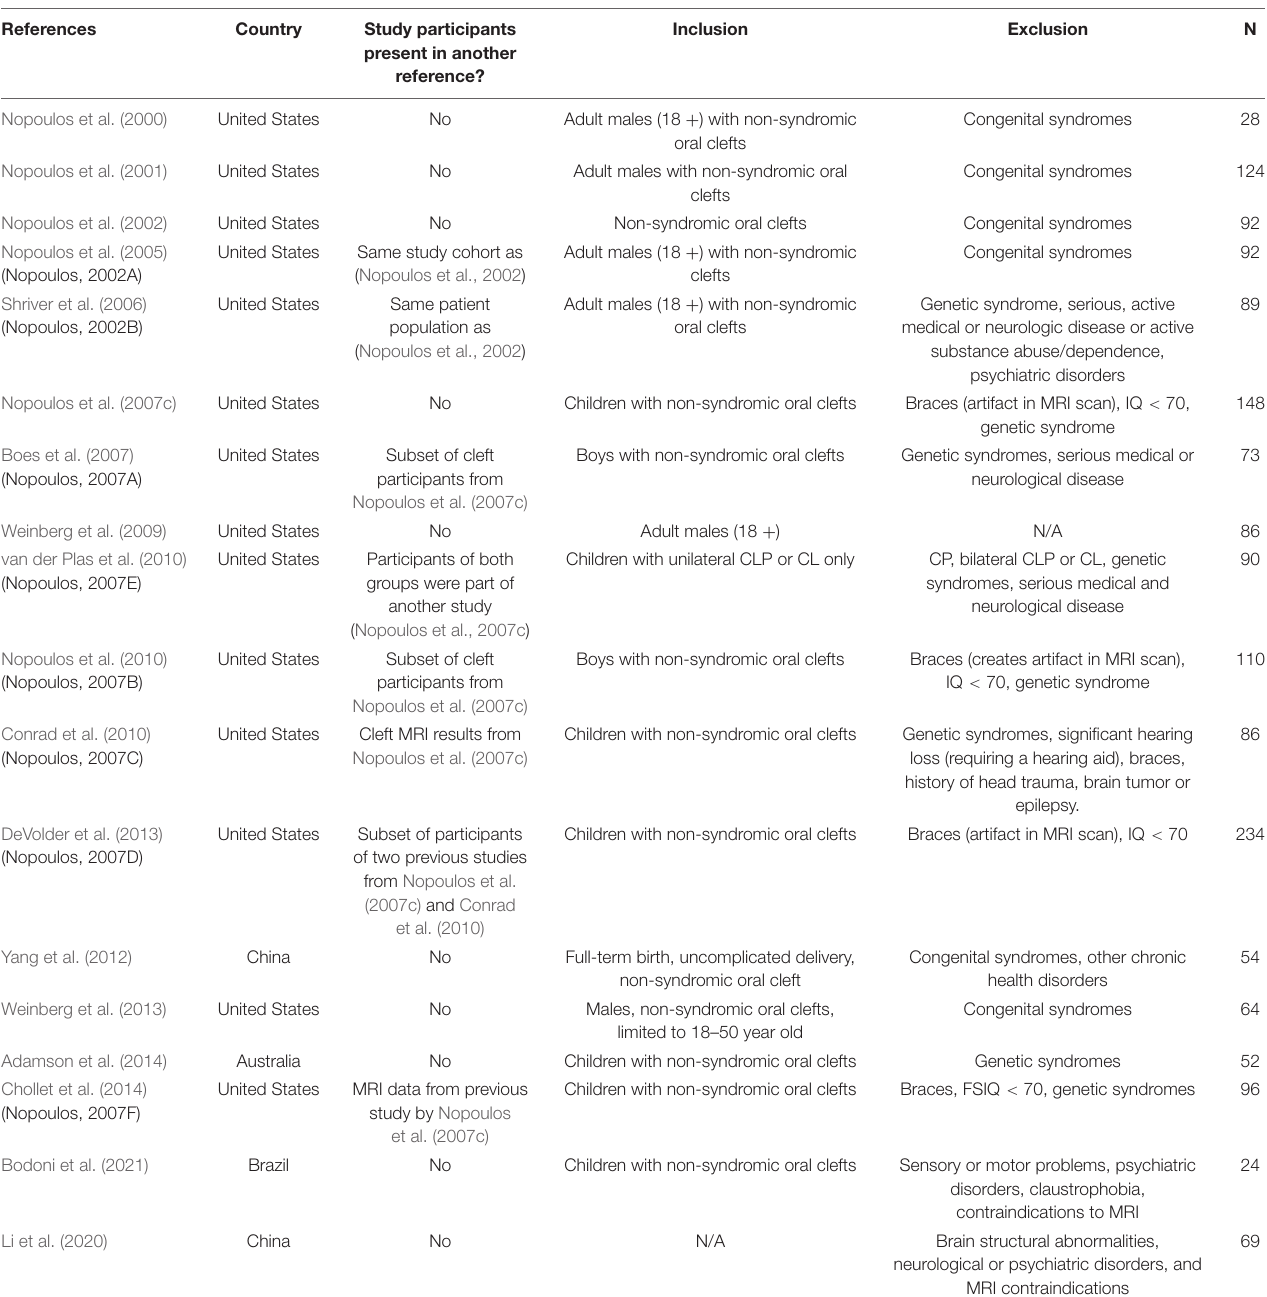
TABLE 1A | Characteristics of included